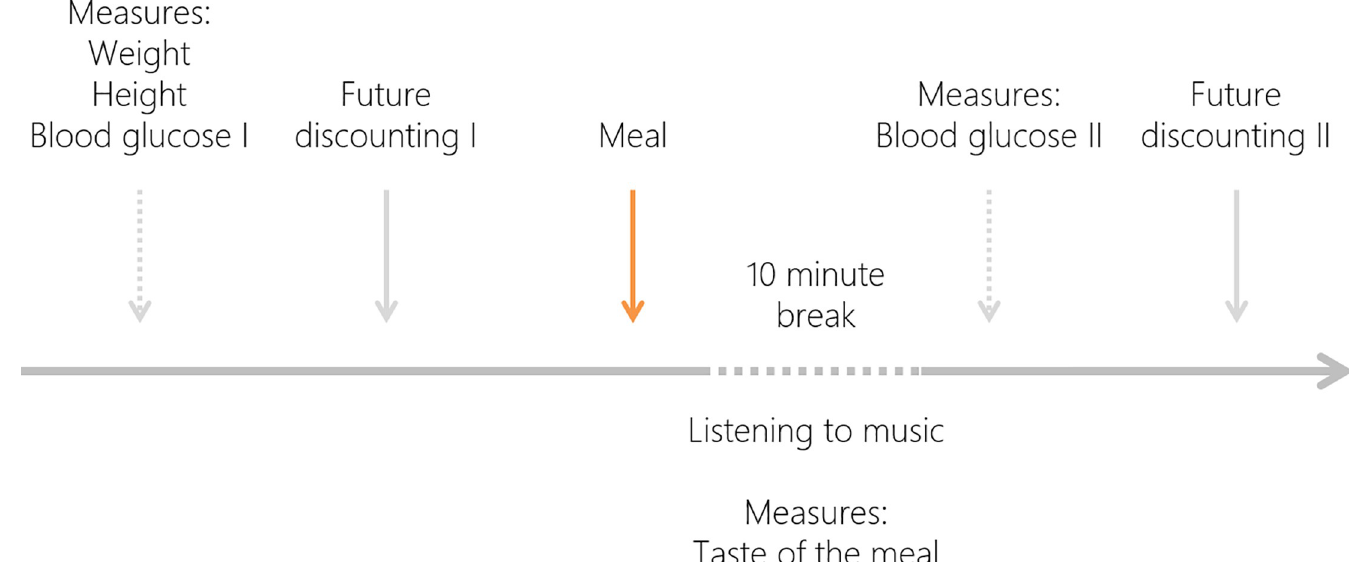
Fig 1. Timeline of the experimental